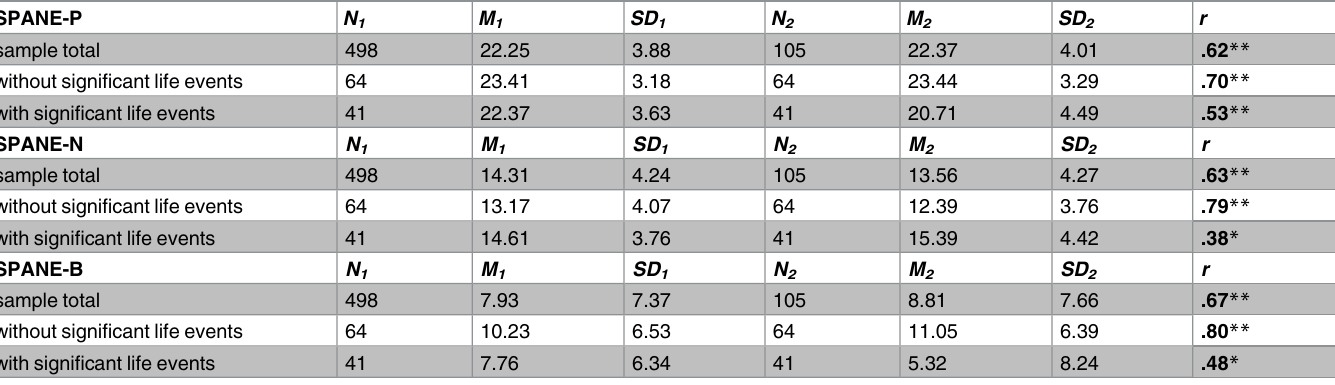
Table 4. Retest-reliability of the German SPANE.